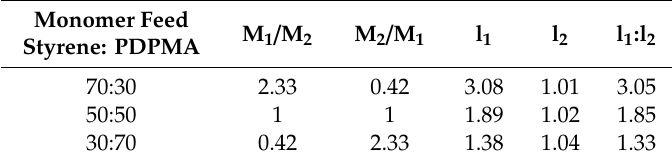
Table 4. The monomer composition and sequence length